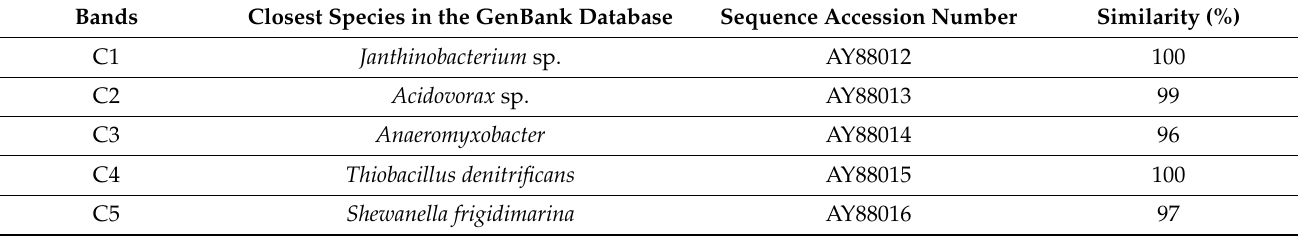
Table 4. Tentative identification of the dominant DGGE bands by sequencing the excised and BLAST analysis. Bands Closest Species in the GenBank